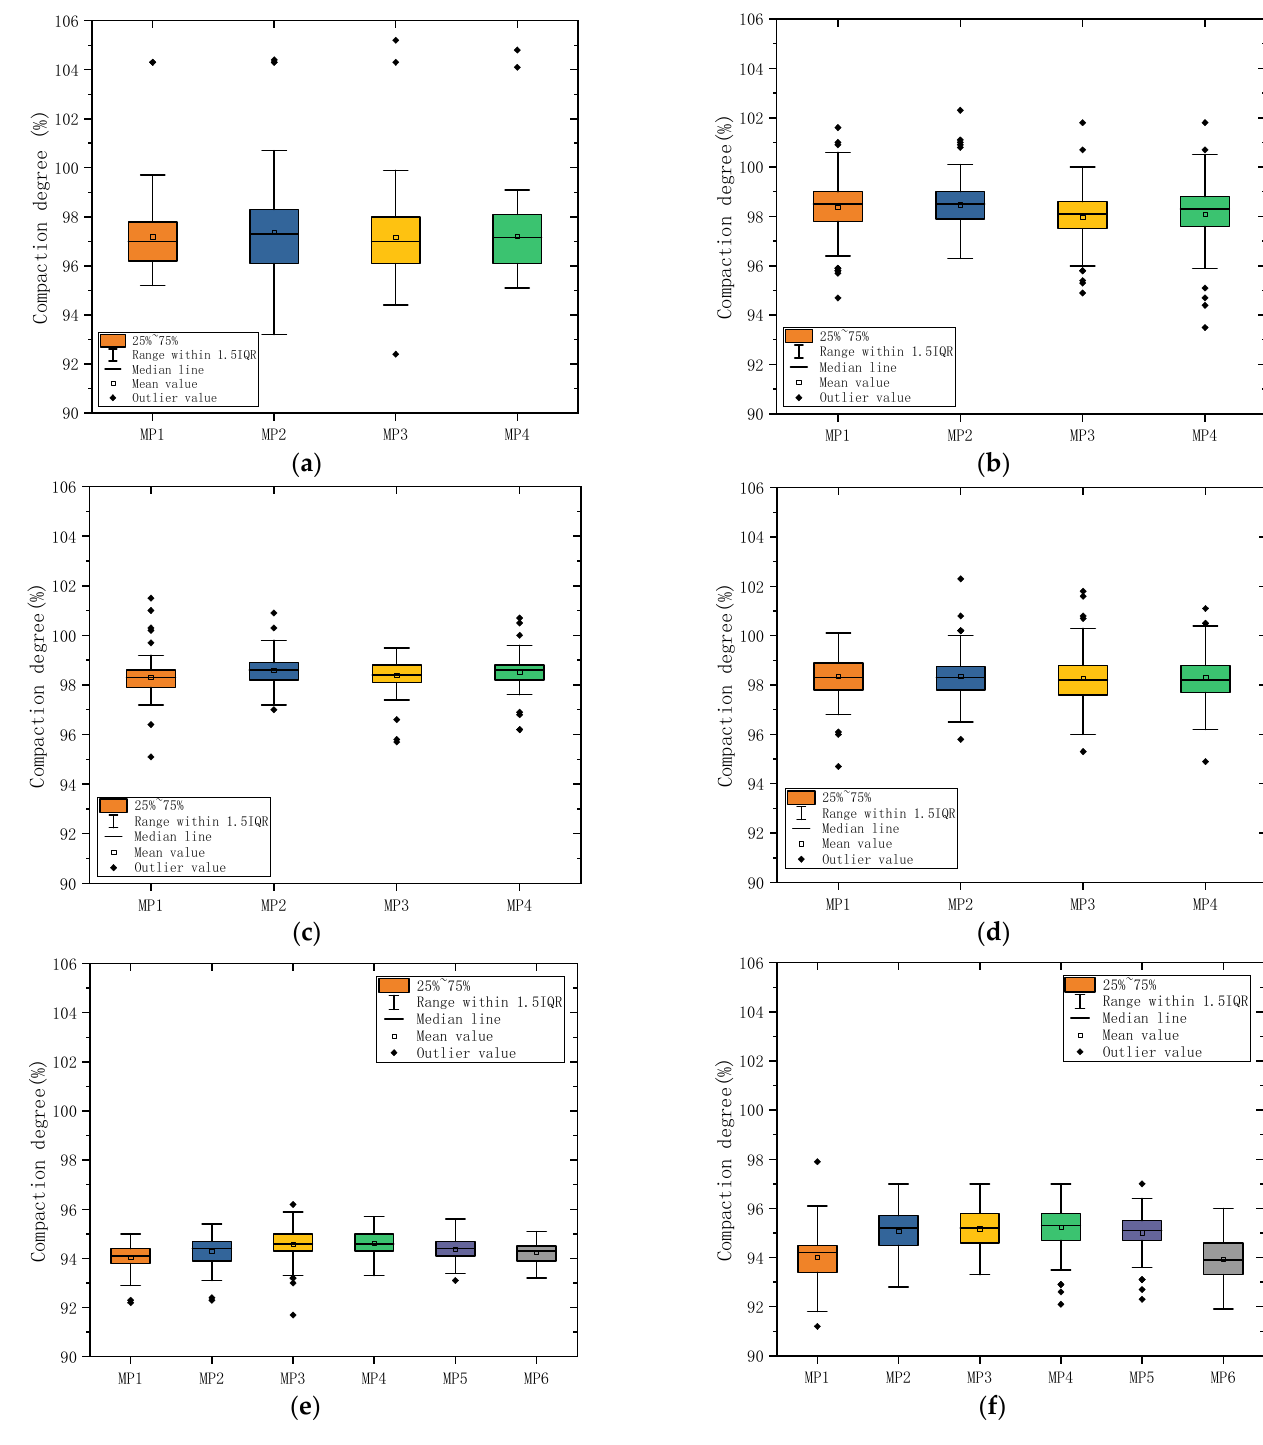
Figure 7. Box plots of compaction degree. ( a ) test section A; ( b ) test section B; ( c ) test section C; ( d ) test section D; ( e ) test section E; ( f ) test section F.